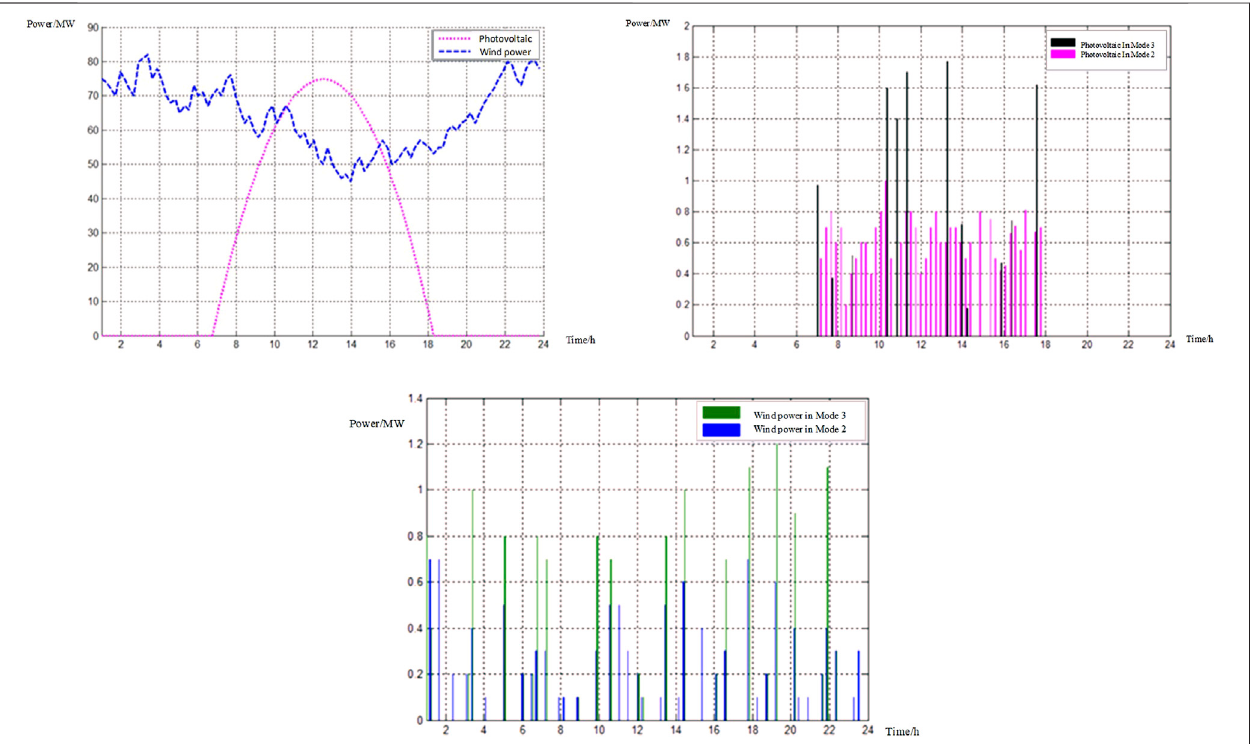
FIGURE5|(A) Thepower ofWTGS, PVinMode 1tothegrid, (B) PVparticipatesinactive power balance and power regulationinMode 2and3, (C) Active power balance regulation power of WTGS in Mode 2 and 3.